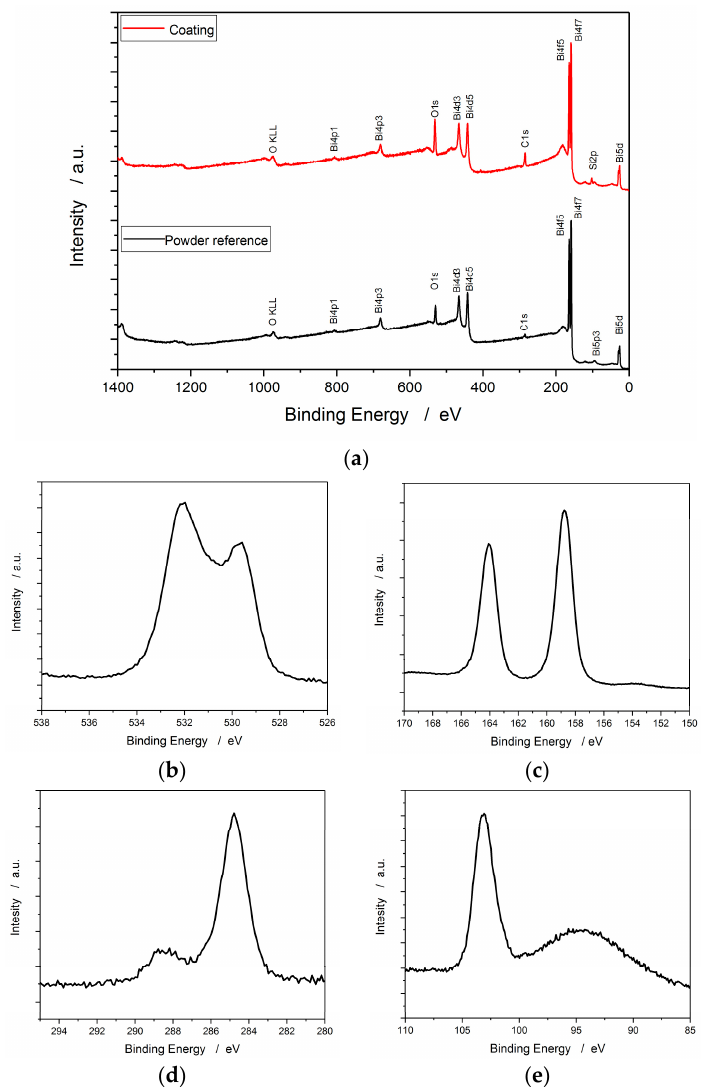
Figure 3. XPS-survey spectra of coating and powder reference ( a ); Detail spectra of coating ( b ) O 1 s , ( c ) Bi 4 f , ( d ) C 1 s ( e ) Si 2 p .